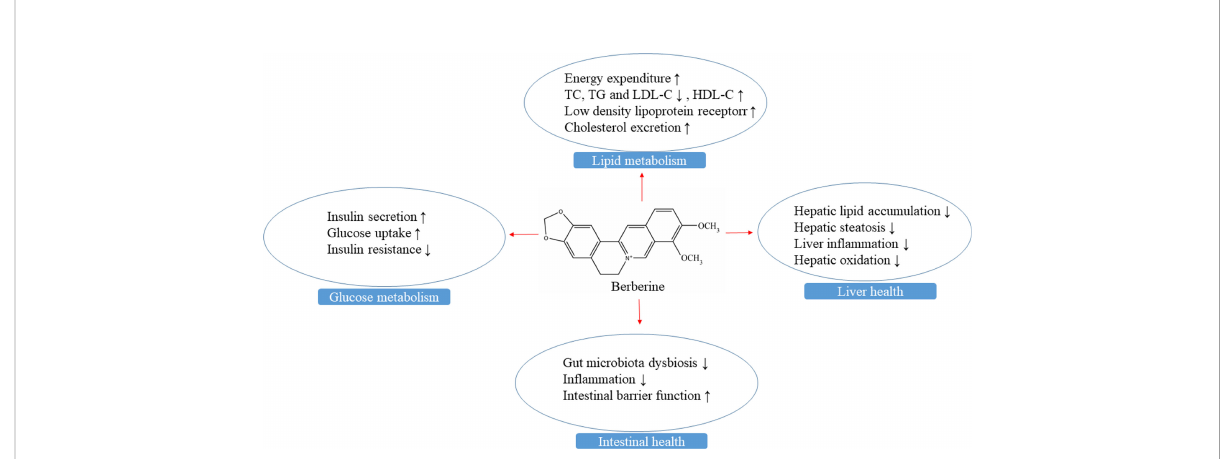
FIGURE 1 The mechanisms of berberine in maintaining liver and intestine health, and glucose and lipid